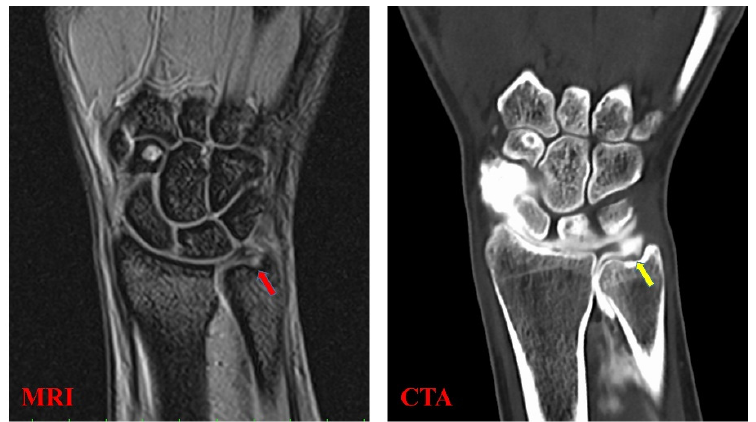
Figure 2. TFCC injury (Palmer type 1B) delineation via magnetic resonance imaging (MRI) and computed tomographic arthrography (CTA). MRI T2* imaging shows a high-intensity line on the disc of the TFCC (red arrow). Moreover, CTA pooling of the contrast medium at the TFCC attachment site of the ulnar head is visible (yellow arrow).